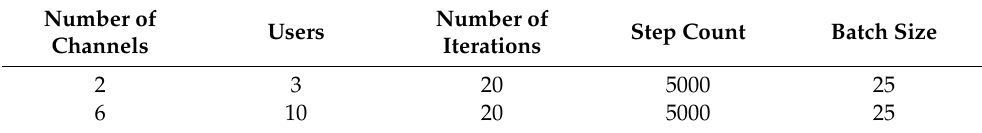
Table 2. Experimental